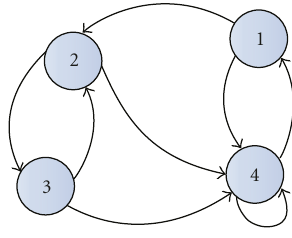
Figure 1: A directed